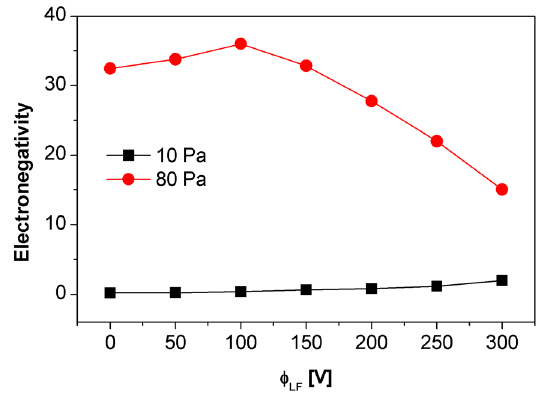
Figure 5 : Electronegativity of classical dual-frequency discharges, operated at 1.937 MHz + 27.12 MHz, as a function of the low-frequency voltage amplitude, Φ , at different pressures (10 Pa and 80 Pa). LF Φ =300 V at 10 Pa and Φ =100 V at 80 HF HF